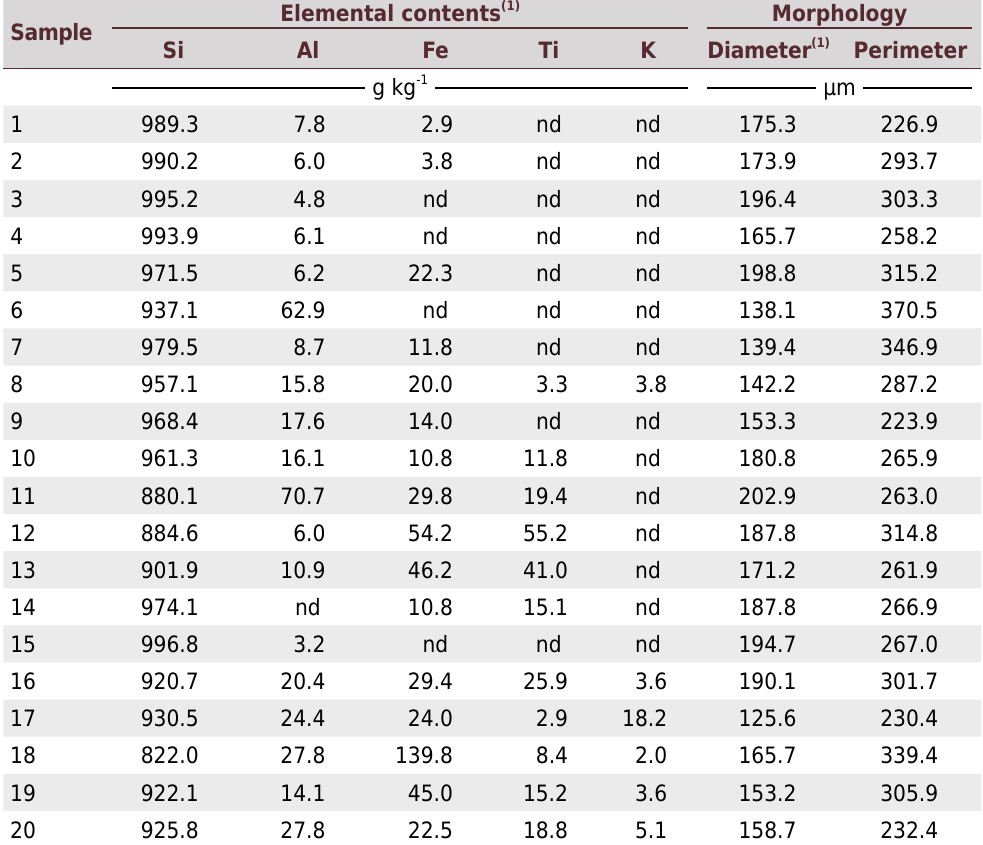
Table 3. Elemental profile and measurements from the grain morphology of the finer sand fraction (<0.25 mm) obtained by SEM-EDS